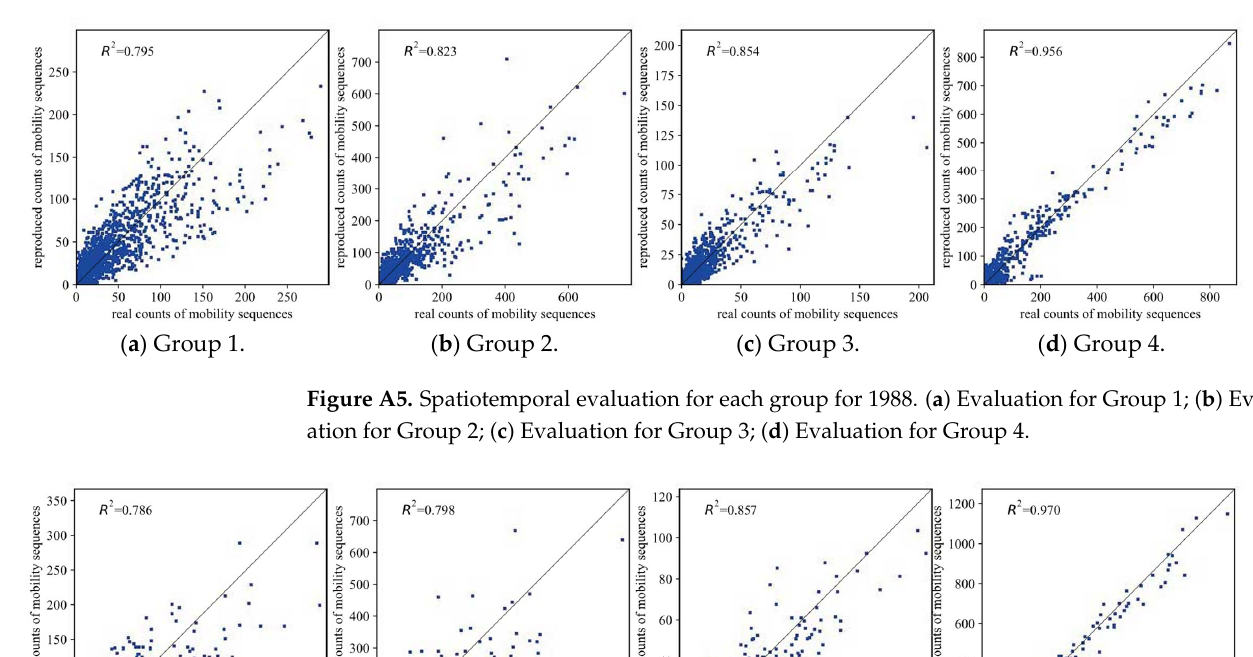
Figure A4. Spatiotemporal evaluation for each group for 1998. ( a ) Evaluation for Group 1; ( b ) Evaluation for Group 2; ( c ) Evaluation for Group 3; ( d ) Evaluation for Group 4.